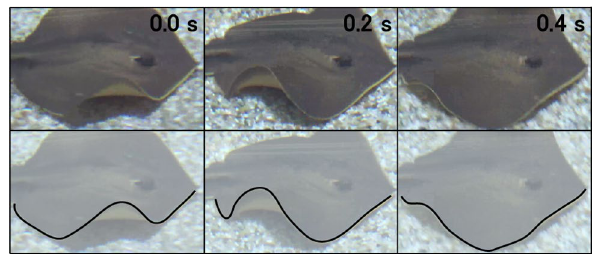
Figure 1. Swimming of a stingray (pictures are taken by the authors). Traveling waves are passing from anterior to posterior along the pectoral fins.